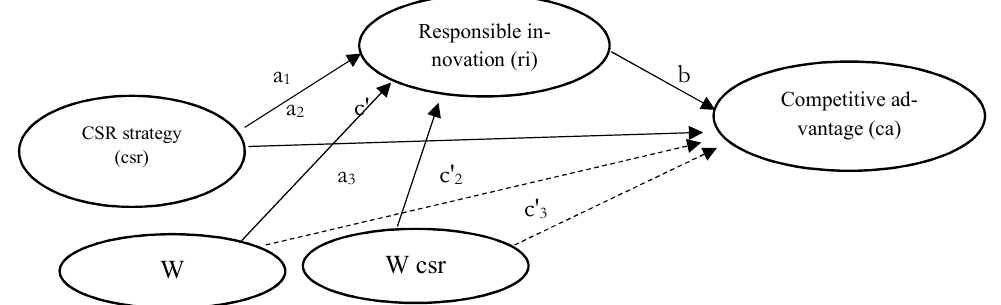
Fig. 2. Statistical model of the moderated mediation of responsible innovation between CSR strategy and competitive ad-